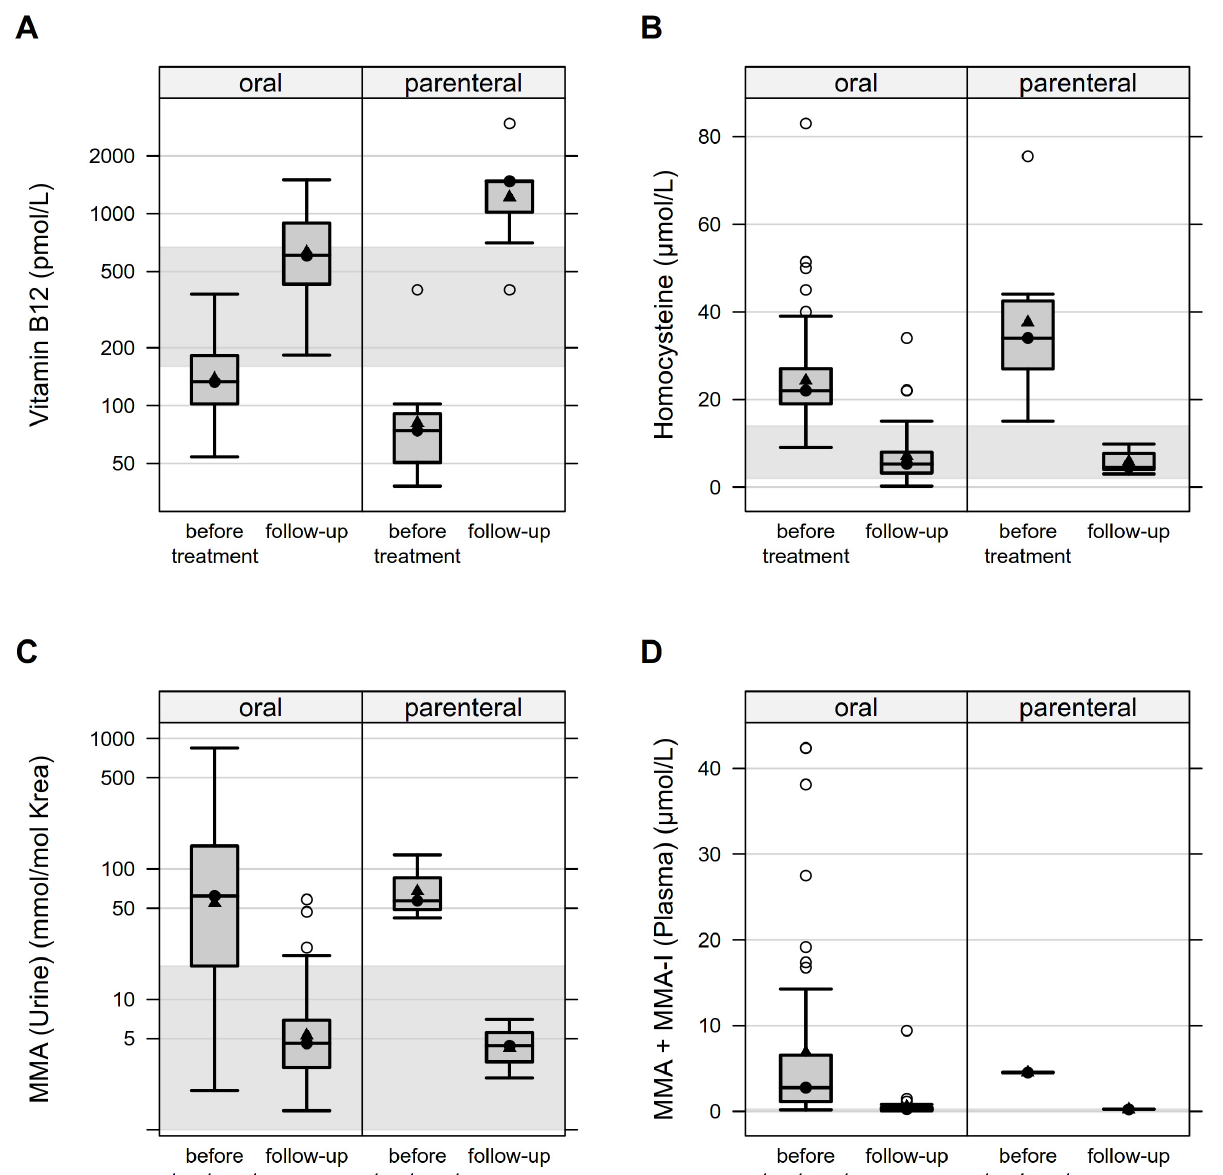
Figure 2. Therapeutic response of vitamin B 12 supplementation: oral versus parenteral administration. Figure 2 ( A – D ) represents the infants’ response to therapy with oral versus also parenteral vitamin supplementation as a boxplot. The gray marked area represents the normal value range. There is an increase in the vitamin B 12 level and a decrease in the functional parameters Hcy, MMA in urine, and MMA or MMA-I in